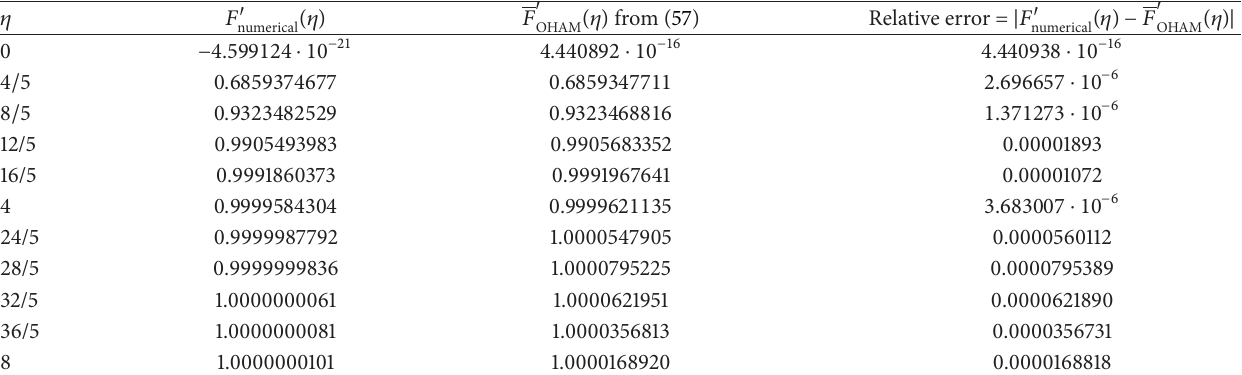
󸀠 (𝜂) obtained from (57) and numerical results for 𝛽 = 1